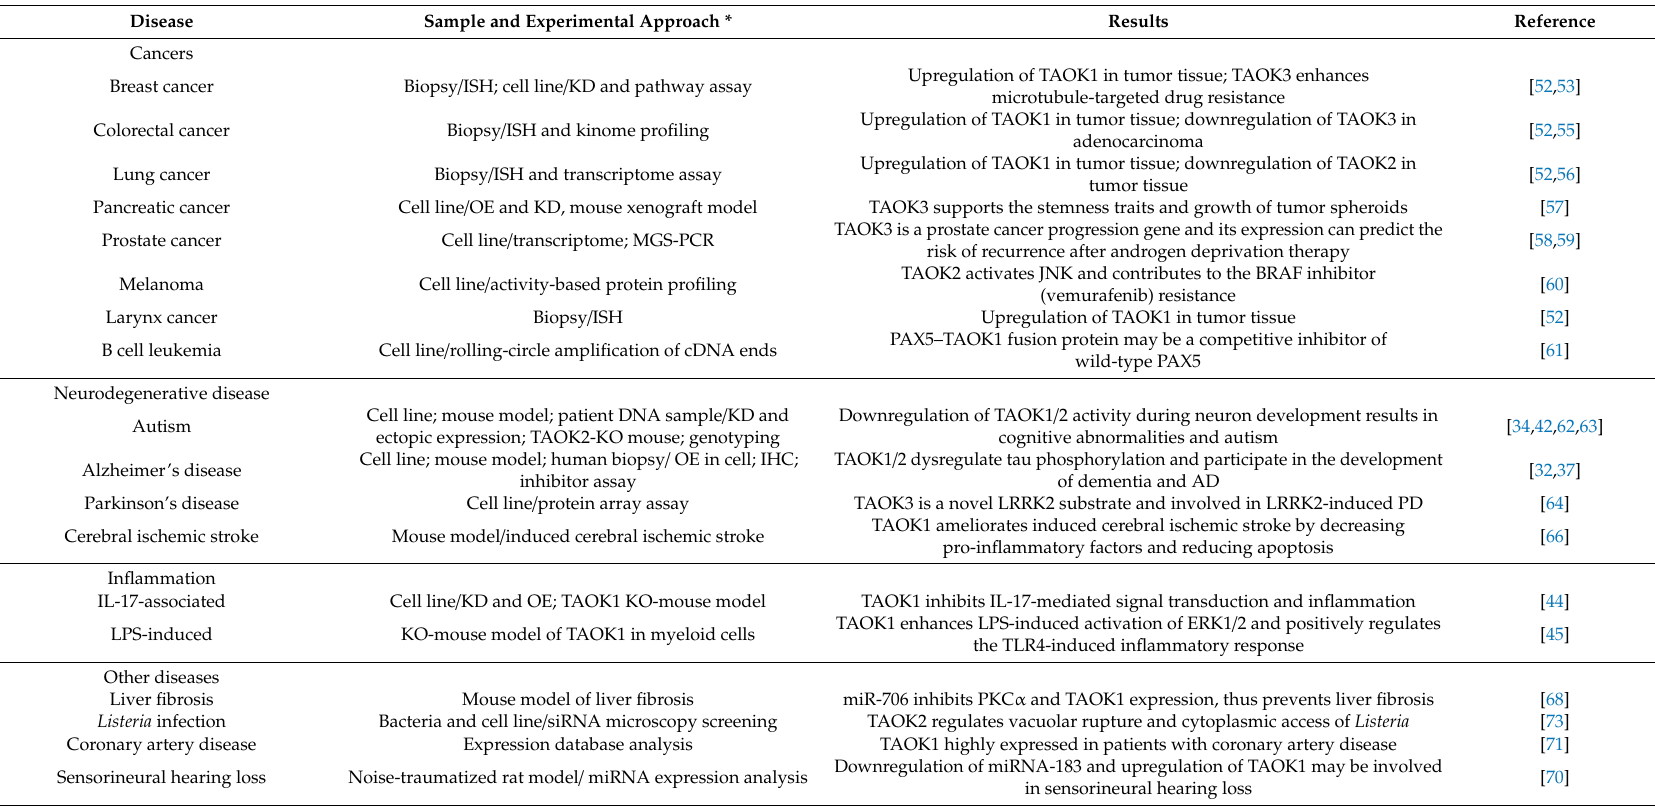
Table 2. The role of TAO kinases in tumorigenesis, inflammation, cognitive / neurodegenerative disorders, and other